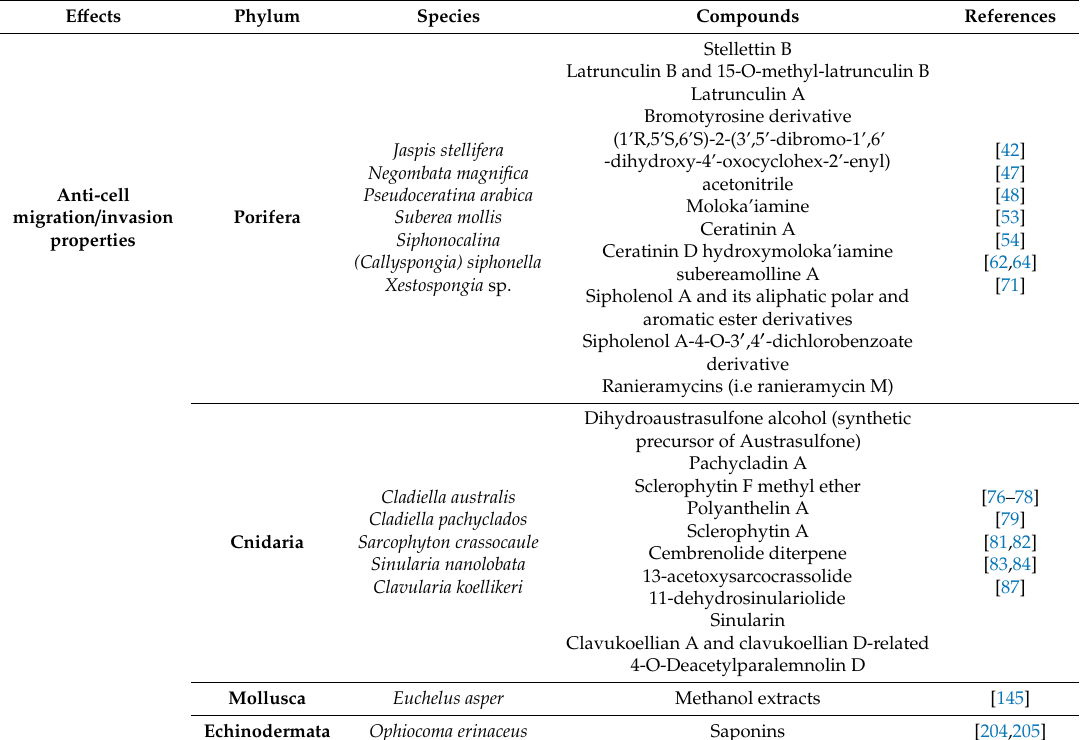
Table 1. Anti-cancer and wound healing-promoting properties of molecules and crude extracts from marine